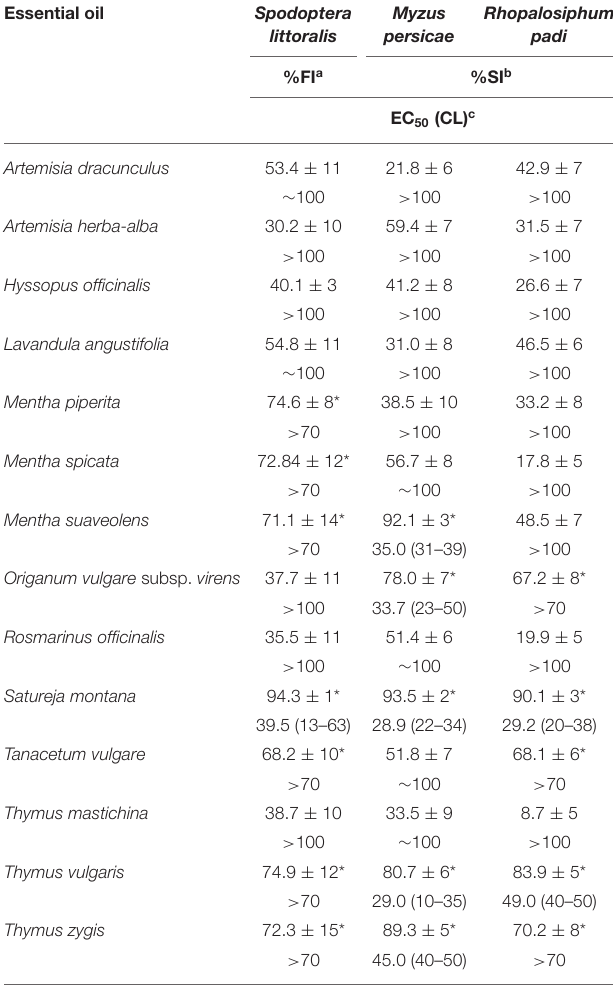
TABLE 3 | Insect antifeedant effects of the selected essential oils. Essential